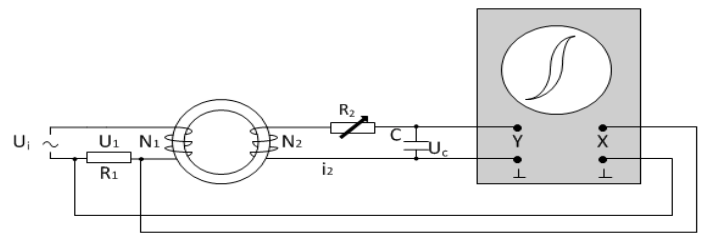
Figure 1. Diagram of dynamic hysteresis loop measurement.